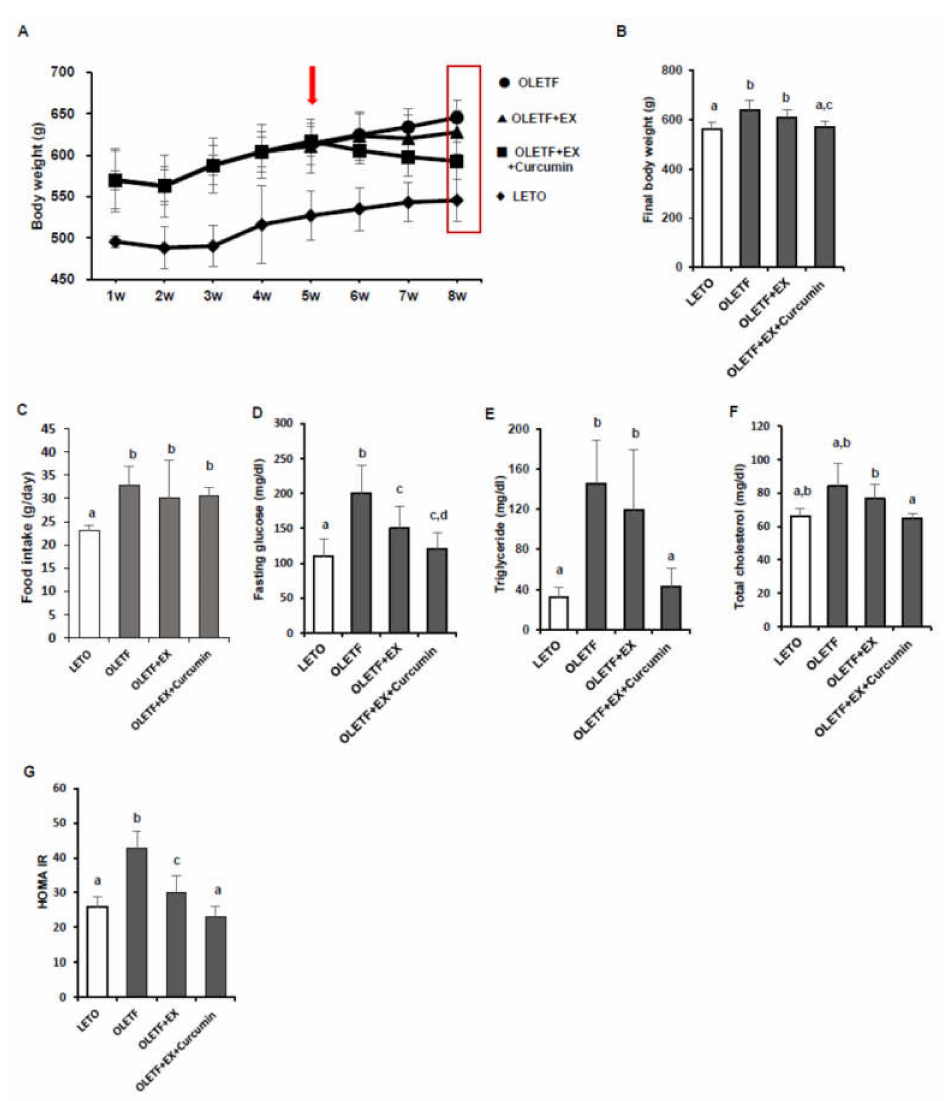
Figure 1. Exercise plus curcumin supplementation reduced body weights and improved glucose homeostasis and lipid profiles in OLETF rats. ( A ) Plot of body weights (g) over the eight weeks experimental for OLETF and LETO controls (10 male rats / group). Arrow indicates a start period of the intervention study in exercise with curcumin supplementation. ( B ) Mean body weight was significantly lower in the OLETF + EX + Curcumin group than for OLETF controls and lower in the OLETF + EX + Curcumin group than in the OLETF + EX group. ( C ) Food intake (g / day) was measured in twice a week. ( D ) Fasting glucose levels were lower in the OLETF + EX + Curcumin and the OLETF + EX groups than in OLETF controls, but no significant di ff erence was observed between these intervention groups. ( E – G ) Serum triglyceride, total cholesterol, and Homeostatic Model Assessment of Insulin Resistance (HOMA-IR) in OLETF and LETO controls. Results are presented as means ± Standard deviations (SDs). Significant di ff erences were determined using One-way ANOVA. Di ff erent superscripts indicate significant di ff erence; a,b,c,d ( p < 0.05). LETO: age-matched control group, OLETF: diabetic group, OLETF + EX: diabetic exercise-trained (to climb a ladder with added weights) group, OLETF + EX + Curcumin: diabetic exercise-trained and fed curcumin (5 g / kg / diet) group. To determine whether exercise plus curcumin supplementation has a beneficial e ff ect on lipid metabolism in OLETF rats, serum triglyceride and total cholesterol levels were analyzed. OLETF controls had significantly higher triglyceride ( p < 0.05) and total cholesterol levels ( p < 0.05) than LETO controls. Interestingly, triglyceride and total cholesterol were significantly lower in